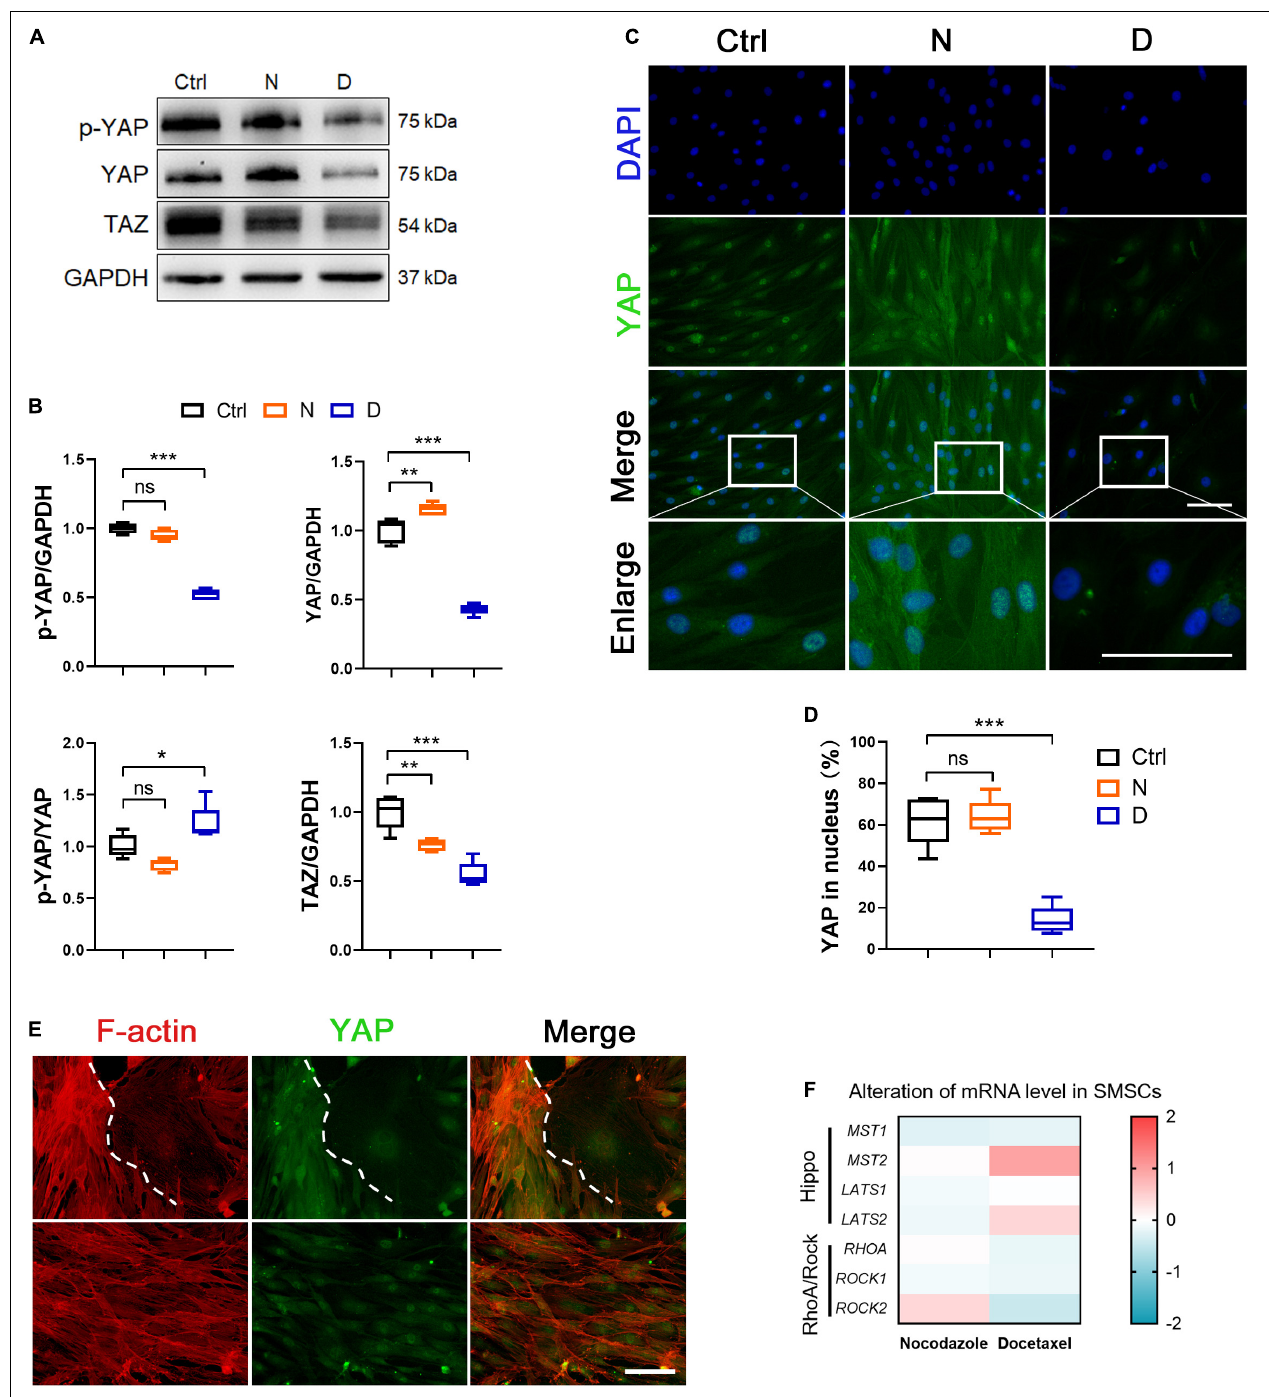
FIGURE 3 | The effect of microtubule (MT) stabilization in YAP expression in SMSCs. (A) Western blot analysis of phosphorylated Yes-associated protein (YAP), total YAP and TAZ expression in synovial mesenchymal stem cells (SMSCs) treated with nocodazole (N) and docetaxel (D) in chondrogenic medium (CM) for 1 week. (B) Quantification of the data of (A) . n = 5. (C) Immunofluorescence staining for YAP of SMSCs. Scale bar, 100 µ m. (D) Quantification of YAP in nucleus. n = 5. MT stabilization inhibited the YAP expression in SMSCs. (E) Co-immunofluorescence staining images of F-actin and YAP in SMSCs without docetaxel or nocodazole treatment (upper panel: view 1; lower panel: view 2). Scale bar, 200 µ m. (F) RT-qPCR analysis of MST1 , MST2 , LATS1 , LATS2 , RHOA , ROCK1 , and ROCK2 in SMSCs treated with either nocodazole (N) or docetaxel (D) for 1 week. Data are represented as the mean ± SEM. * p < 0.05, ** p < 0.01, *** p < 0.001.